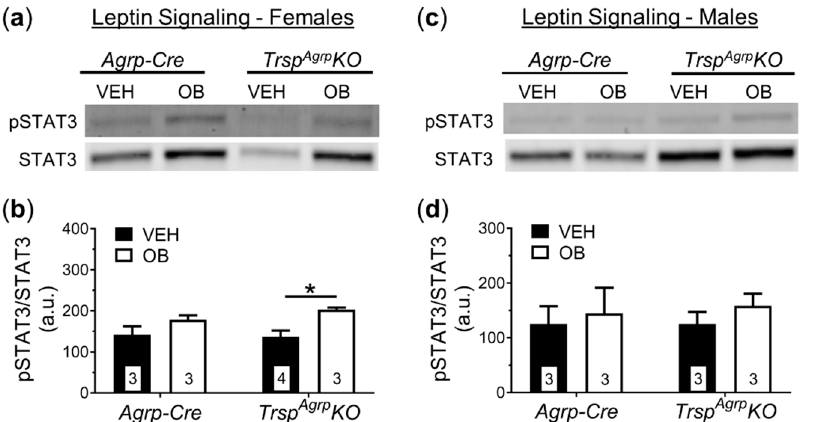
Figure 4. Western blot analysis of broad hypothalamic leptin signaling in Trsp Agrp KO mice of both sexes raised on a high-fat diet. Leptin (OB) injection did not elicit a significant increase in phosphorylated STAT3 (pSTAT3) protein levels in female Agrp-Cre control mice compared to vehicle (VEH)-injected Agrp-Cre mice ( a , b ). Female Trsp Agrp KO mice, however, displayed an increase in pSTAT3 levels in response to leptin injection (two-way analysis of variance, followed by Tukey’s multiple comparisons test: * p = 0.04). Leptin injection failed to significantly elevate pSTAT3 protein levels in the hypothalamus of either Agrp-Cre or Trsp Agrp KO male mice ( c , d ). Samples sizes are displayed in the graphs. All values shown are mean ± standard error of the mean.